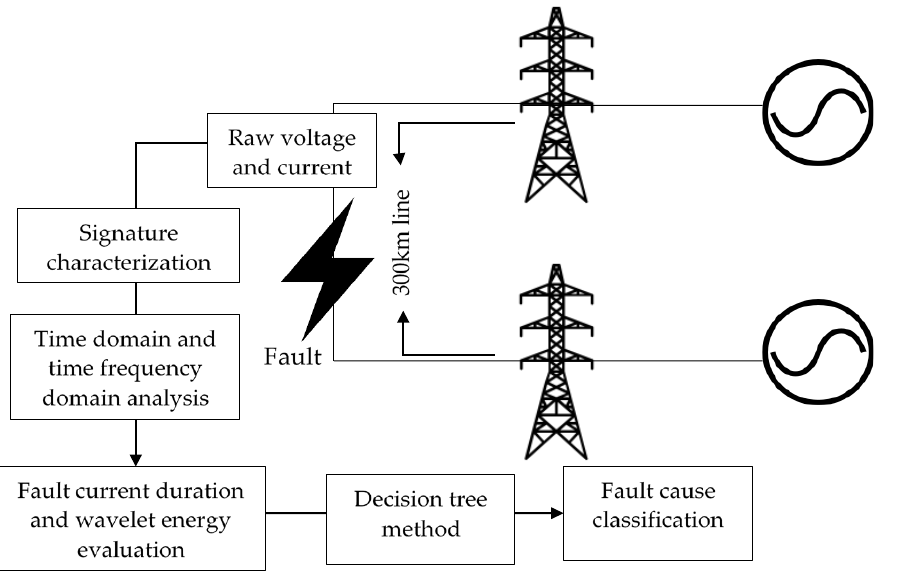
Figure 1. Transmission line fault simulation process.